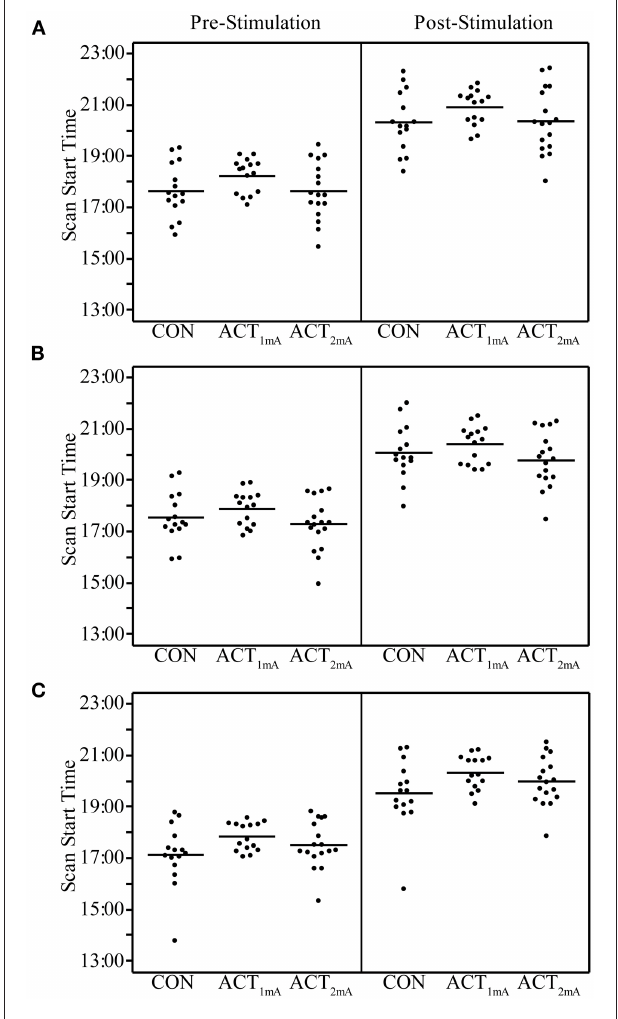
FIGURE 2 | Pre- and post-stimulation scan start times for session 1 (A) , session 2 (B) , and session 3 (C) separated by group. Group averages are indicated by the